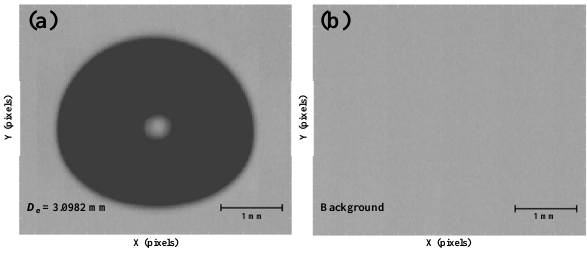
Figure 2. (a) Sample image of a water drop photographed using a high-speed camera. The drop appears as a dark area, and the small, brighter area near the drop center is due to the bright-field illumi- nation adopted in this study. (b) Corresponding background image taken just before the drop fell into the view frame of the